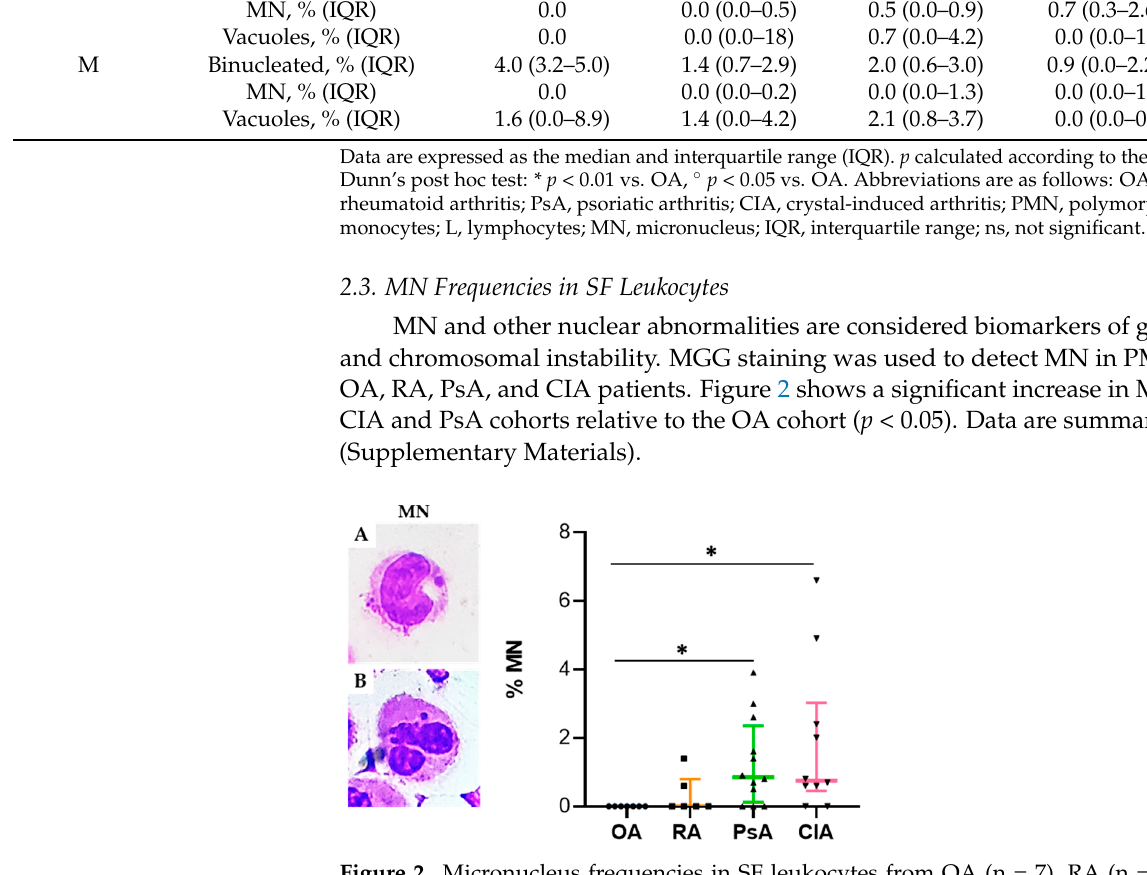
Table 2. Cytogenic and cellular morphology evaluation of PMN and M in SF from OA (n = 7), RA (n = 6), PsA (n = 12) and CIA (n = 10) patients.